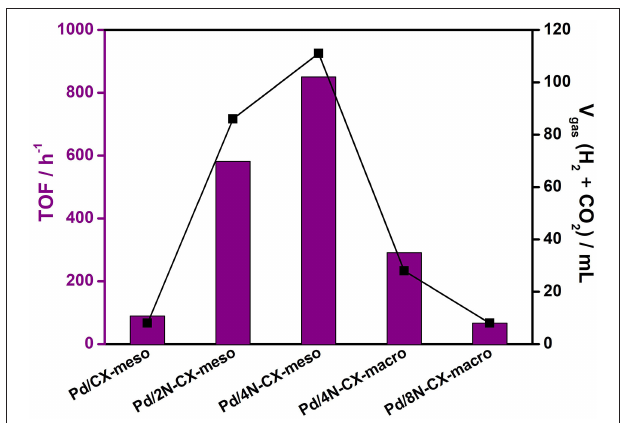
FIGURE 9 | Gas generated after 1h of reaction at 75 ◦ C for the PdCo/g-C 3 N 4 set of catalysts along with Pd and Co monometallic